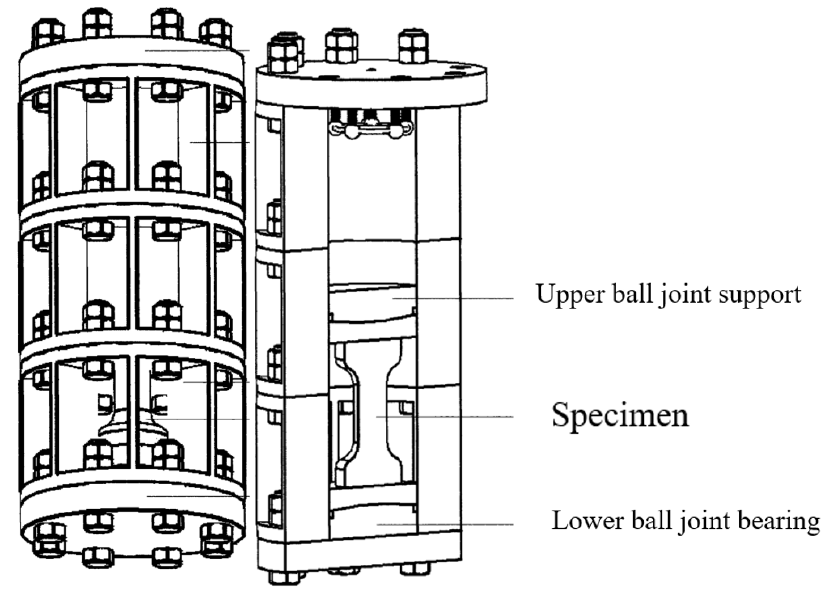
Figure 2. Plane wave explosive test device diagram.